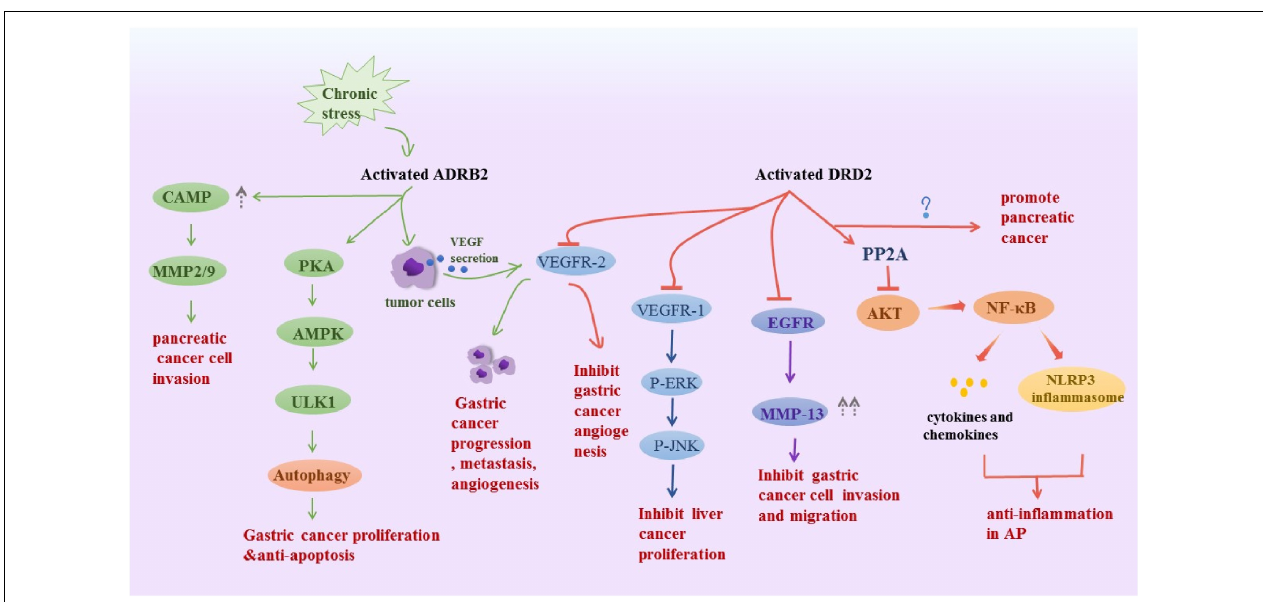
FIGURE 2 | Schematic representation summarizes the DRD2 and ADRB2 signaling in digestive disease. Activated ADRB2 induced pancreatic cancer cell invasion by accumulation of cAMP, promoted gastric cancer proliferation and anti-apoptosis through inducing autophagy. Also, it promoted gastric cancer progression metastasis, angiogenesis via VEGFR-2. The DRD2 signaling activates PP2A and inhibited the phosphorylation of Akt and NF-kappa B to control inflammation, However, it promoted pancreatic cancer, the underlying mechanism is unknown. Besides, it inhibits tumor angiogenesis by inhibiting VEGFR-2 phosphorylation in gastric cancer endothelial cells. DRD2 activation suppresses gastric cancer cell invasion and migration via inhibition of EGFR/AKT/MMP-13 pathway. Moreover, it downregulated VEGFR1, p-ERK and pJNK to ameliorate liver cancer